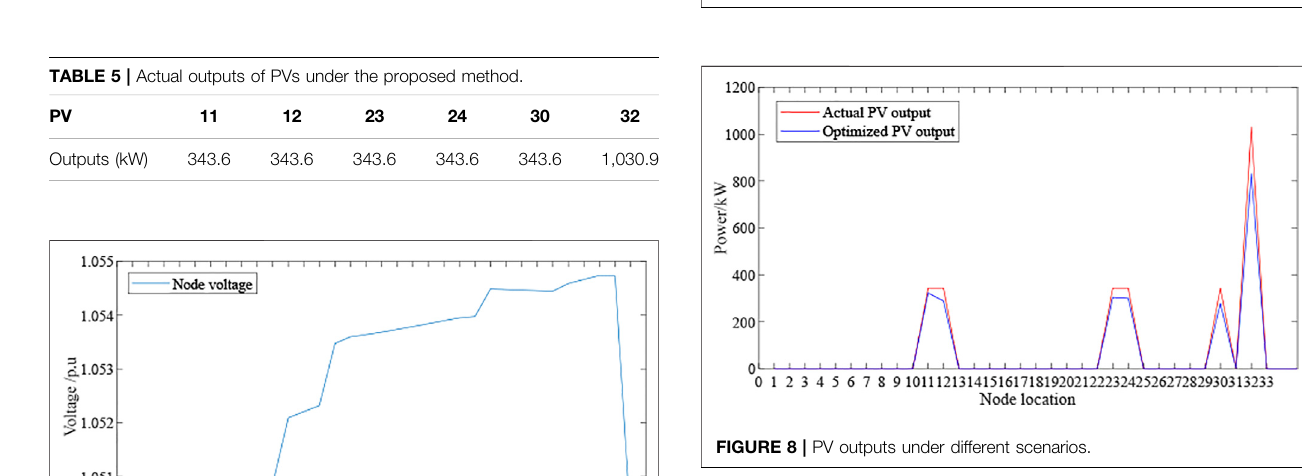
FIGURE 7 | Optimized nodal voltage under the proposed method.